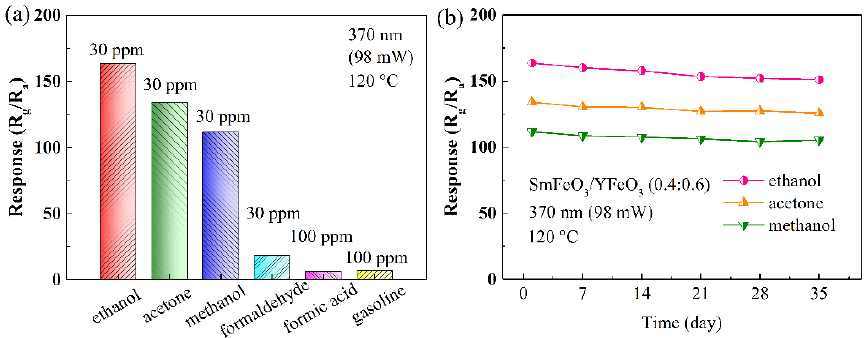
Figure 13. ( a ) Response histogram of the SmFeO 3 /YFeO 3 (0.4:0.6) sensor for VOC gases at 120 ◦ C; ( b ) stability curves of the SmFeO 3 /YFeO 3 (0.4:0.6) sensor for VOC gases at 120 ◦ C within 35